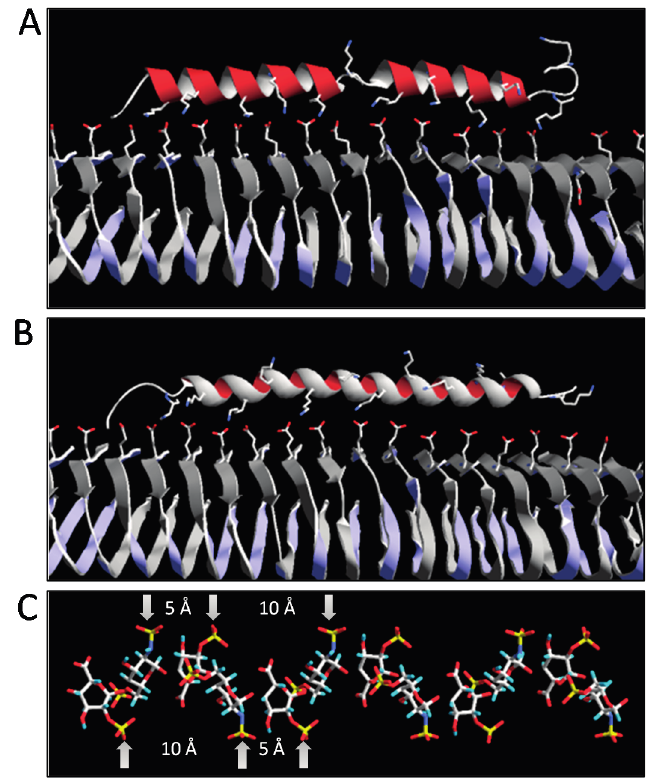
Figure 9. Molecular dynamic simulation of peptide p5+14 with an archetypal A β (17-42) amyloid fibril shows the dependence of electrostatic interactions. ( A ) Binding of peptide p5+14 (red helix) to the A β fibrils (blue beta strands; PDB# 1BEG), in a milieu of 0.1 M ionic strength, involves interactions between lysine sidechains of the peptide (blue) and the glutamate 22 side chains of the arrayed A β monomers (red); ( B ) In a medium of 1.0 M (PDB# 1HPN) with linear spacing of charged moieties with a 5 Å or 10 Å